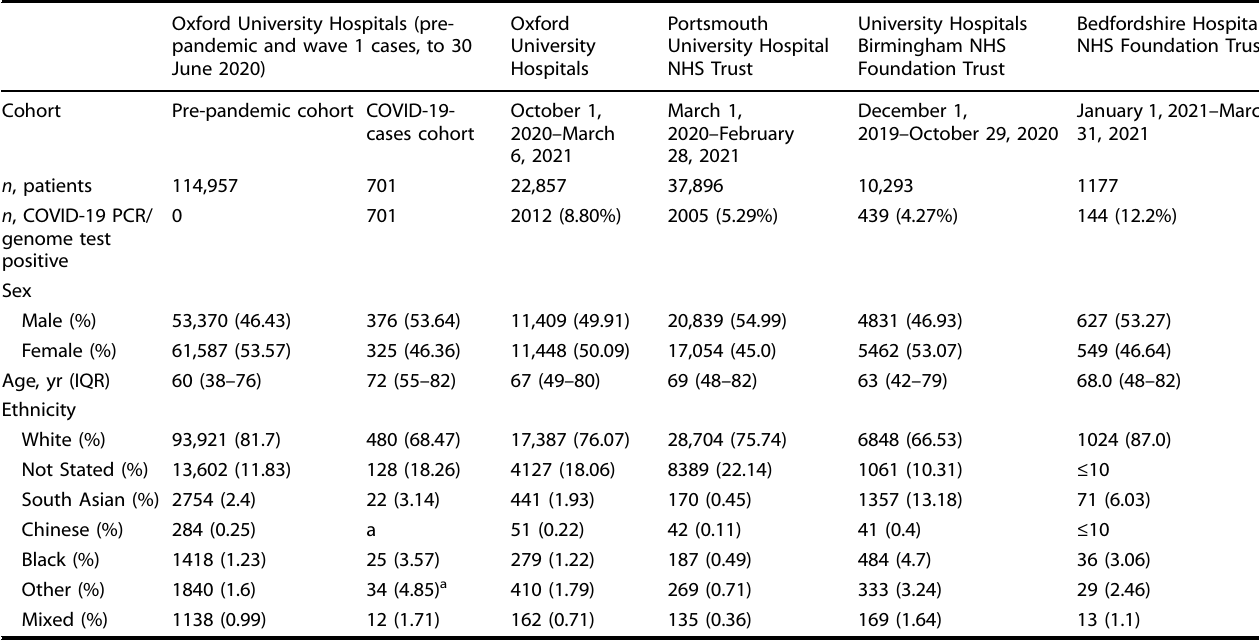
Table 1. Summary population characteristics for OUH, PUH, UHB, and BH